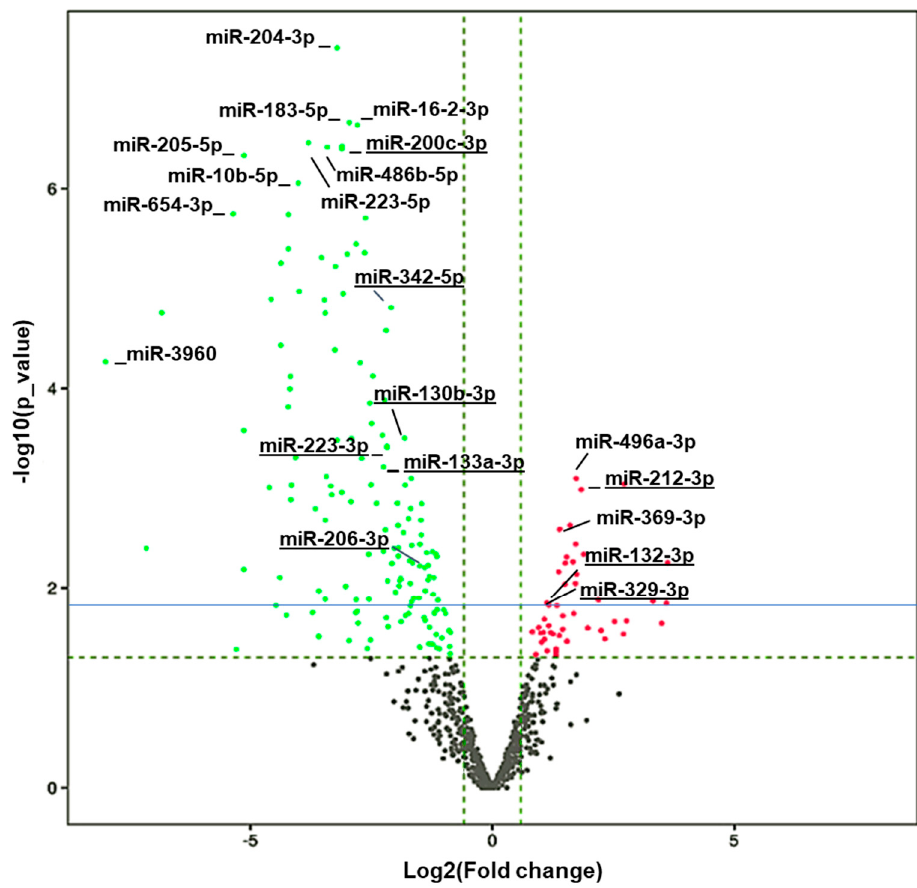
Figure 3. Volcano plot showing differential expressed (DE) miRNAs. Vertical dashed green lines represent the log2(FC) cut off of 2-fold, while the horizontal line green refers to the p value cut off of p = 0.05 expressed as –log( p value), and the solid blue line corresponds to an FDR = 0.1. Differentially downregulated miRNAs are shown in green and differential upregulated ones are shown in red. The names of some of the top upregulated and downregulated miRNAs are provided as reference. Underlined miRNAs have been previously associated with cocaine-seeking behavior [46].